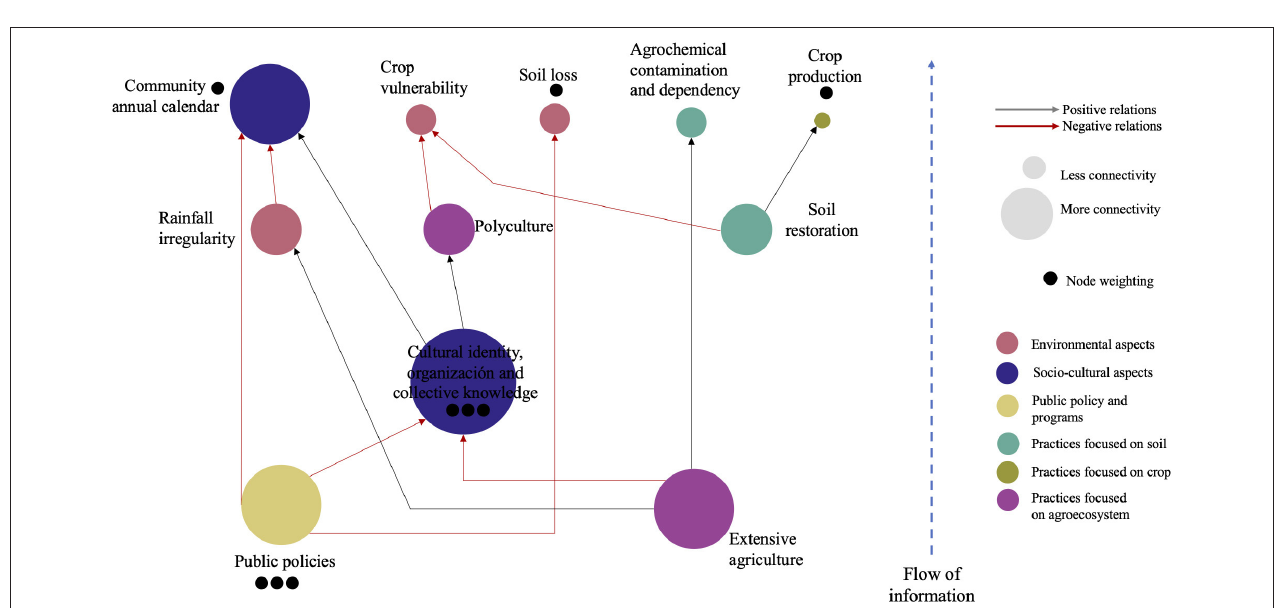
FIGURE 6 | Top ten nodes for the CAP CM based on centrality measures. Size of the nodes correspond to connectivity. Black dots represent the weighting scores.